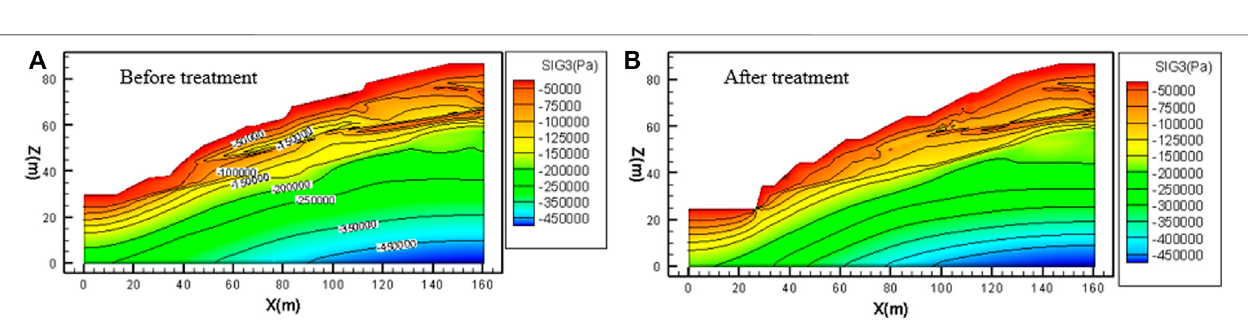
FIGURE 11 | Minimum principal stress nephogram before and after treatment. (A) : Before treatment, (B) : After treatment.